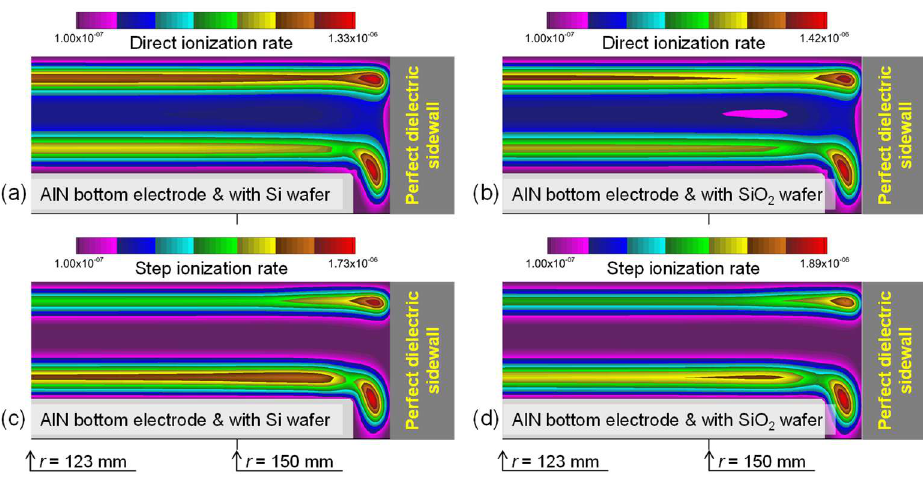
Figure 5. Effects of the dielectric constant of the wafer on the spatial distribution of the plasma parameters. Contour plots for the spatial profiles of the time-averaged SiH 2+ production rate (kmol·m −3 ·s −1 ) for ( a ) Case 6 and ( b ) Case 7 for r ≥ 123 mm. Contour plots for the spatial profiles of the time-averaged Si + production rate (kmol·m −3 ·s −1 ) ( c ) for Case 6 and ( d ) for Case 7 for r ≥ 123 mm. The profiles are radially uniform for r < 123 mm.